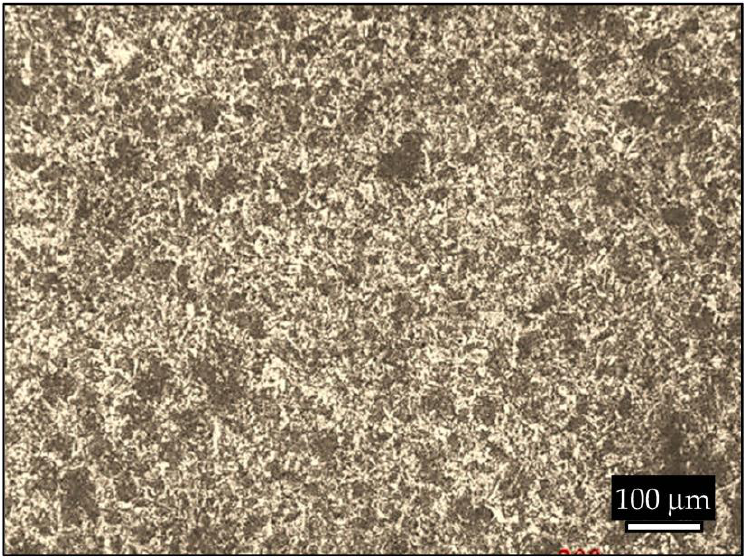
Figure 2. Microstructure of the as-received rebar.